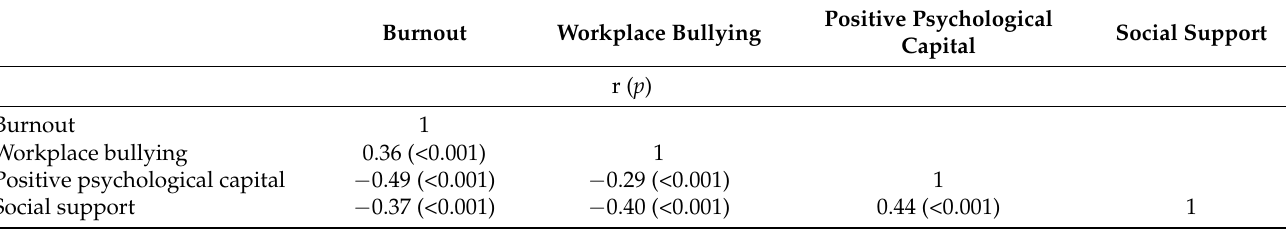
Table 3. Correlation between burnout and workplace bullying, positive psychological capital, and social support ( n = 166).